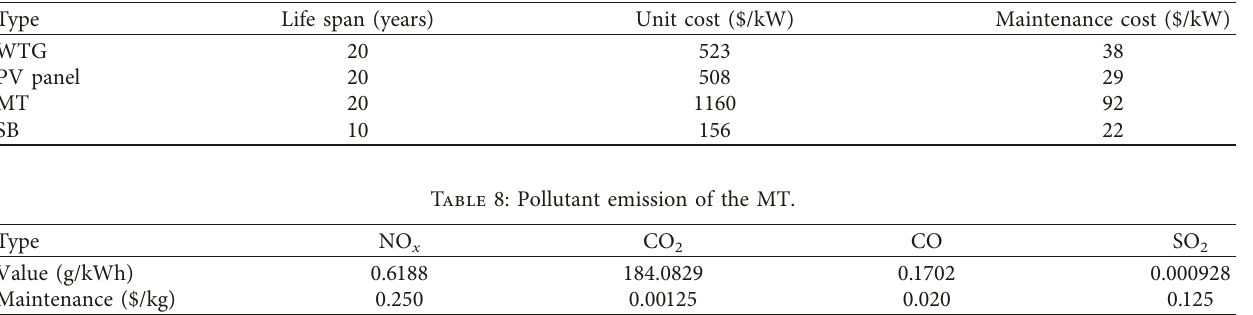
Table 7: Cost values.